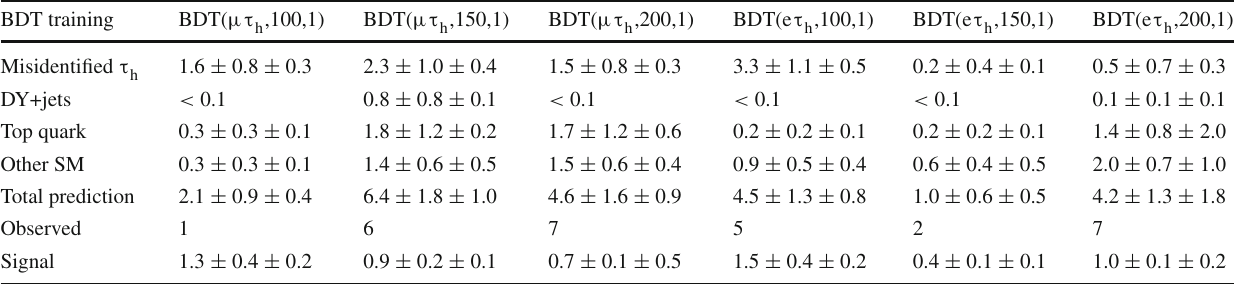
Table 5 Predicted background yields and observed event counts in the for left-handed (cid:2) τ pair production that is used to train the BDT. In the most sensitive last bins of the BDT distributions in the e τ and μτ bottom row, we list the corresponding predicted signal yields in the last h h final states, in data collected in 2016. The numbers in parentheses in bin of the BDT distribution. The first and second uncertainties given the first row are the (cid:2) τ and (cid:2) χ 0 masses corresponding to the signal model are statistical and systematic, 1